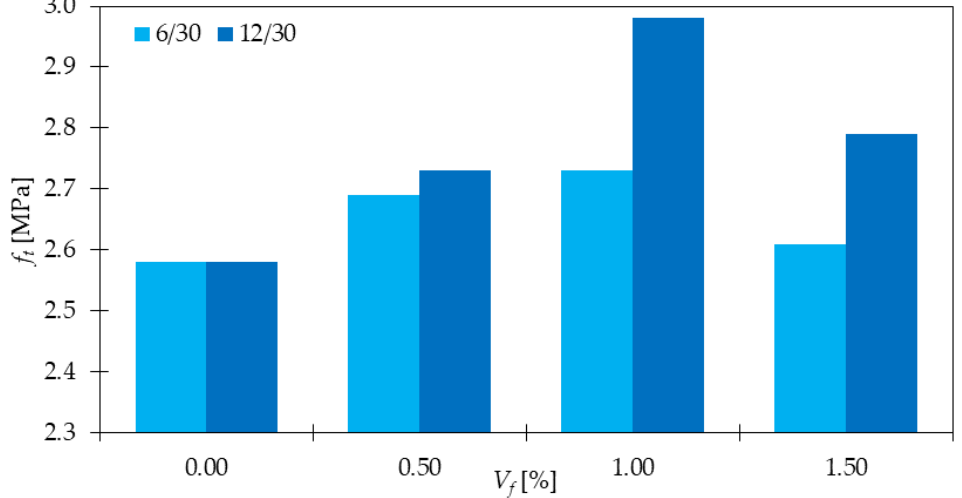
Figure 10. Influence of V f on f t for different fiber geometry l f /d f [14].